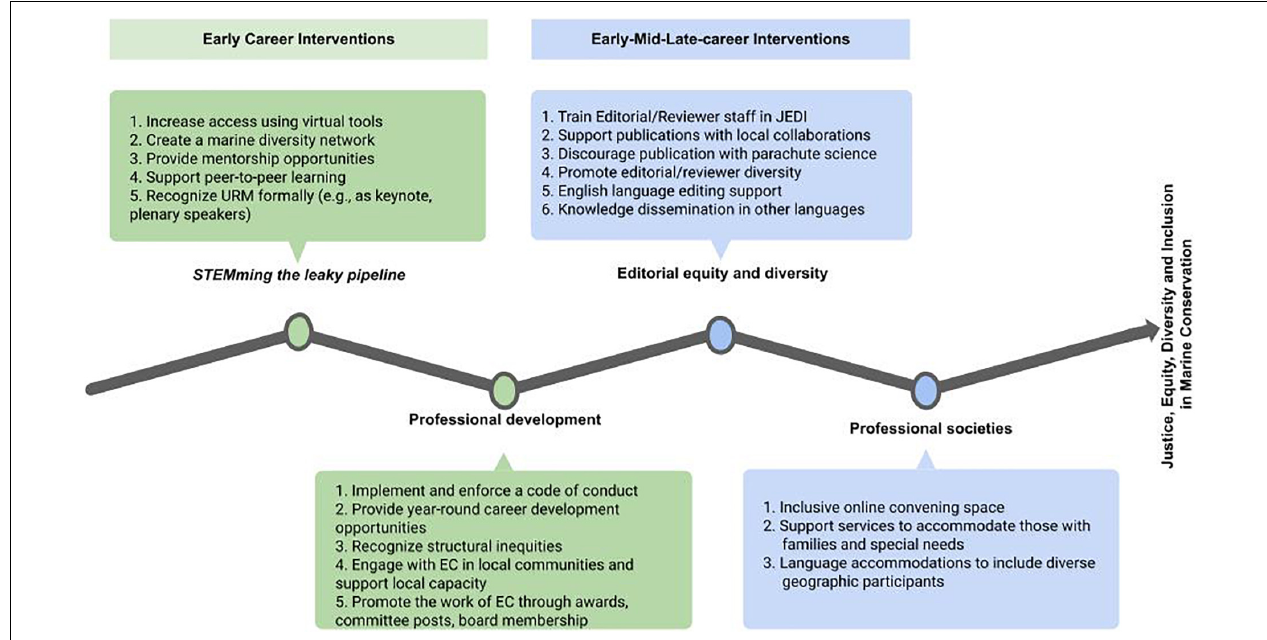
FIGURE 2 | Summary of actionable recommendations to remove barriers to equity, diversity, and inclusion at different career stages in the marine conservation space.